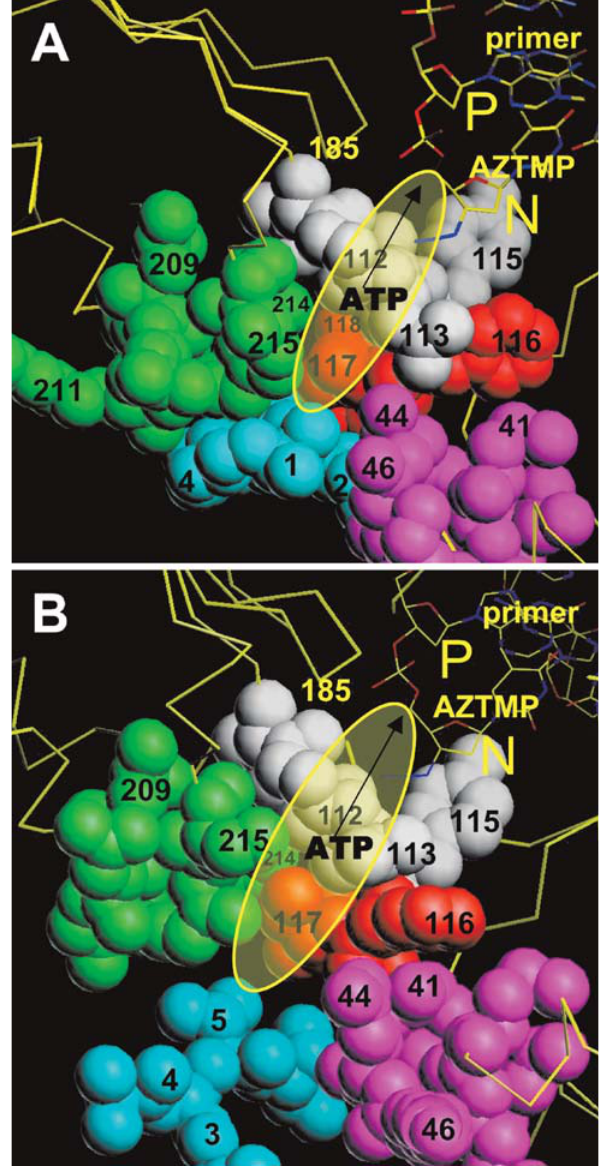
Figure 5. Polymerase Active Site Regions of HIV-1 RT and of HIV-2 RT (A) The HIV-1 RT complex with an AZTMP-terminated primer trapped at the N site (PDB code 1N6Q). (B) Nucleic acid from (A) superposed on the structure of unliganded HIV-2 RT (PBD code 1MU2). The side chains of amino acid residues proximal to